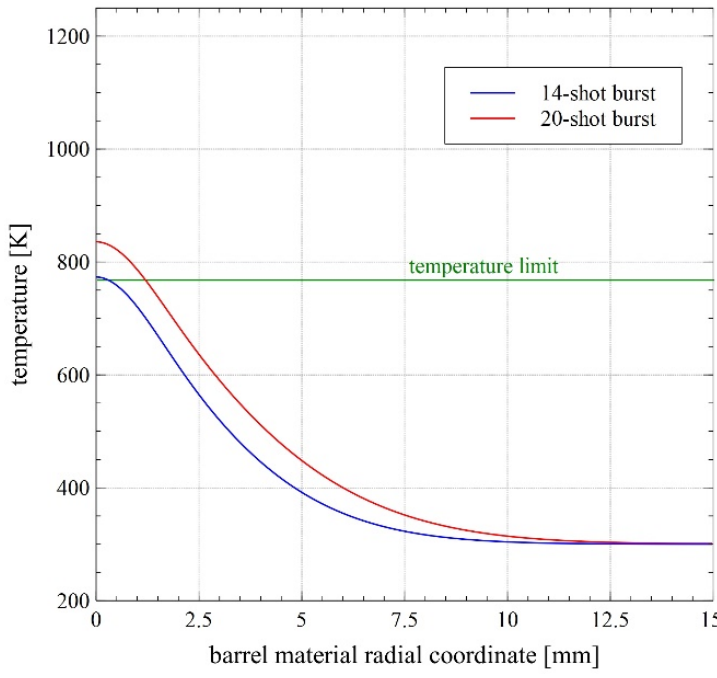
Figure 20. Barrel material temperature radial distribution.